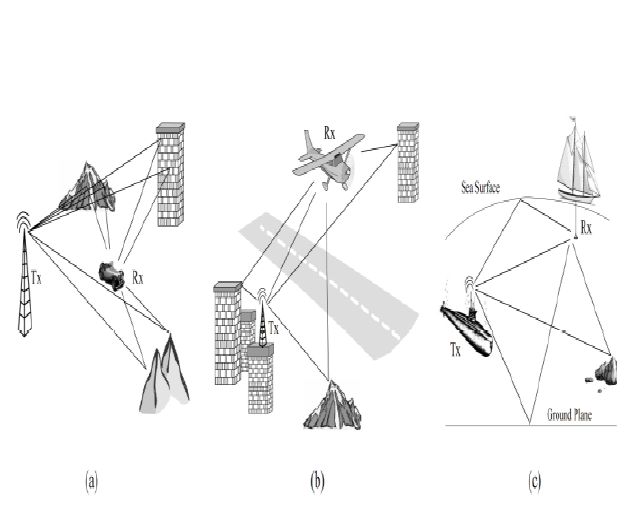
Figure 1: Multipath Phenomenon